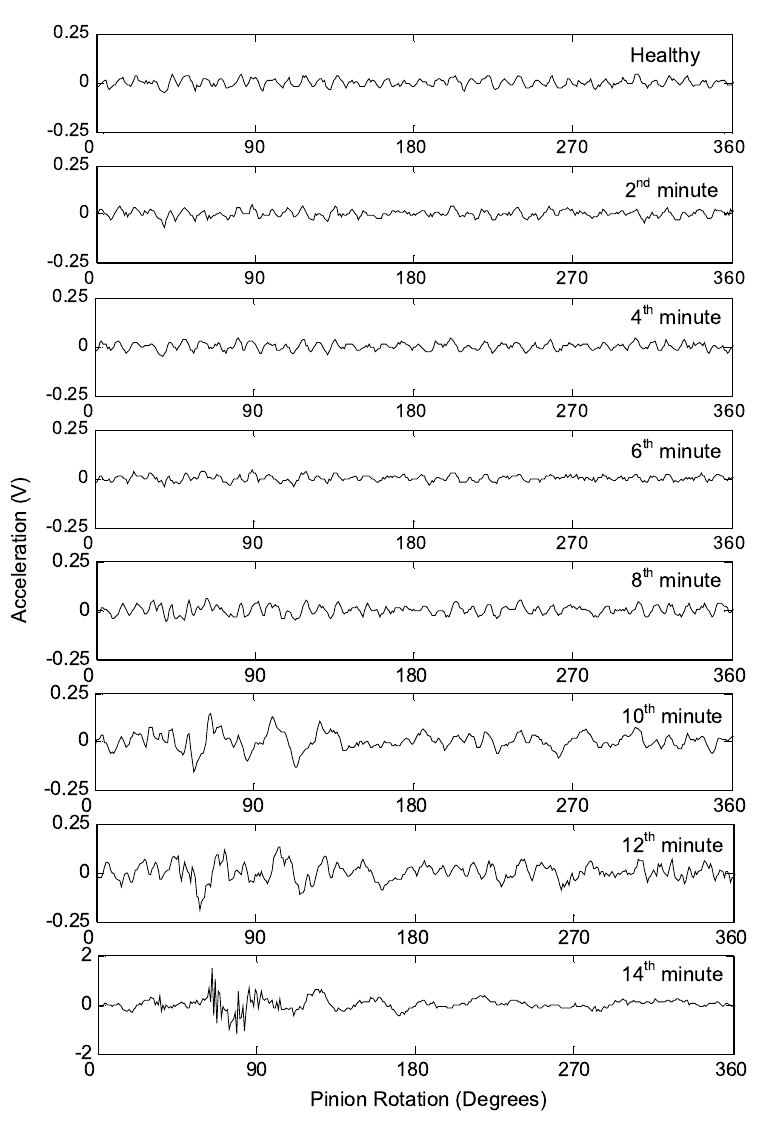
Fig. 9. Averaged residual gear vibrations monitored at two-minute intervals during the fatigue